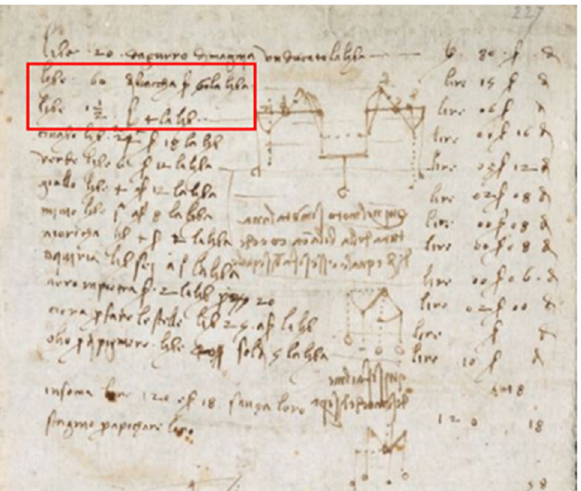
Figure 5. Leonardo da Vinci, Arundel Manuscript 263, detail of f.227v© British Library Board, all rights reserved. The red rectangle indicates two lines where Leonardo mentioned an order for 5 lb of a lead white at 3 lira per pound, and of 1.5 lb of another batch of lead white at 4 lira per